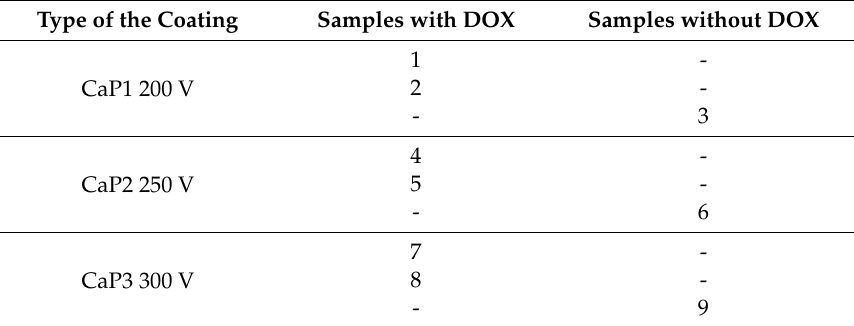
Table 2. Scheme of the CaP coatings treatment with DOX.